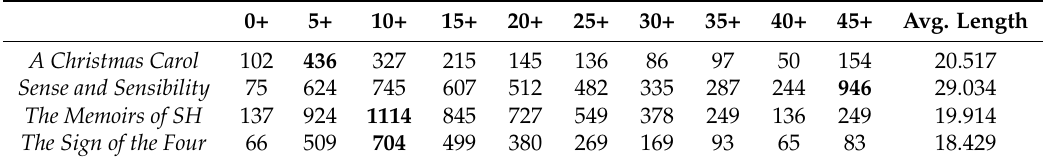
Table 3. Distribution of sentence length (in tokens) and average sentence length (in tokens) in the STs of each novel.